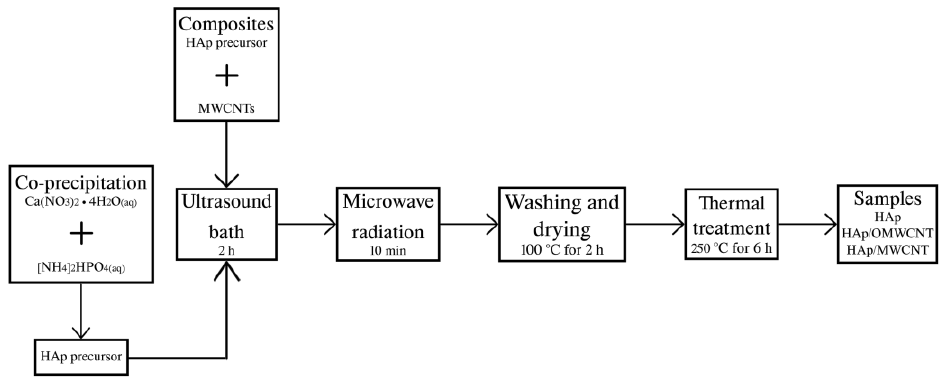
Figure 1. Diagram of the synthesis of HAp and HAp/OMWCNT and HAp/MWCNT composites.